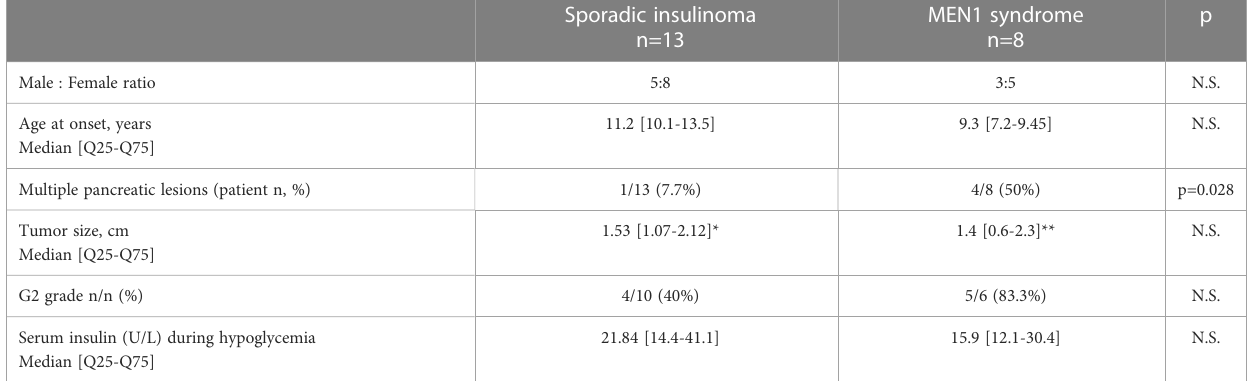
TABLE 4 Comparative analysis of the clinical features in pediatric patients with sporadic vs. MEN1-associated